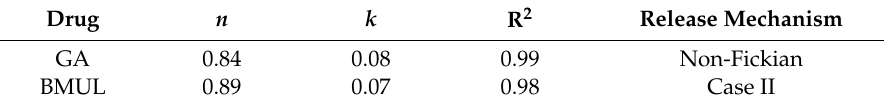
Table 7. Parameters of Korsmeyer–Peppas model for GA and